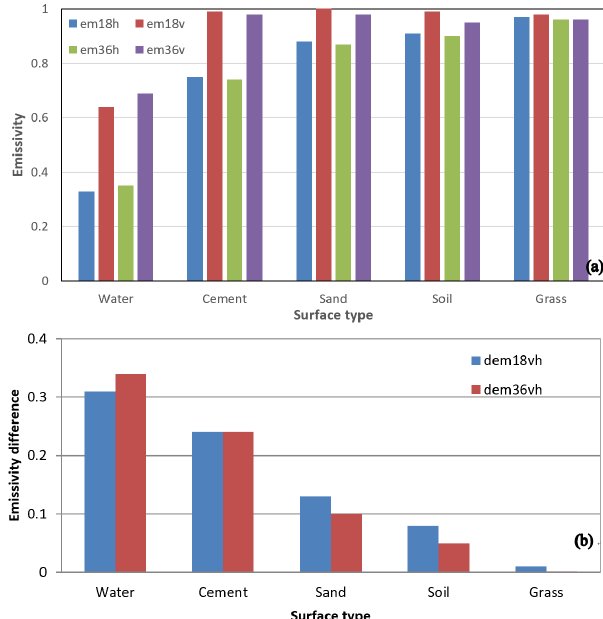
Figure 7. Variations in the surface emissivity (a) and emissivity po- larization differences (b) over different land surfaces at 02:00 (BJT) in October